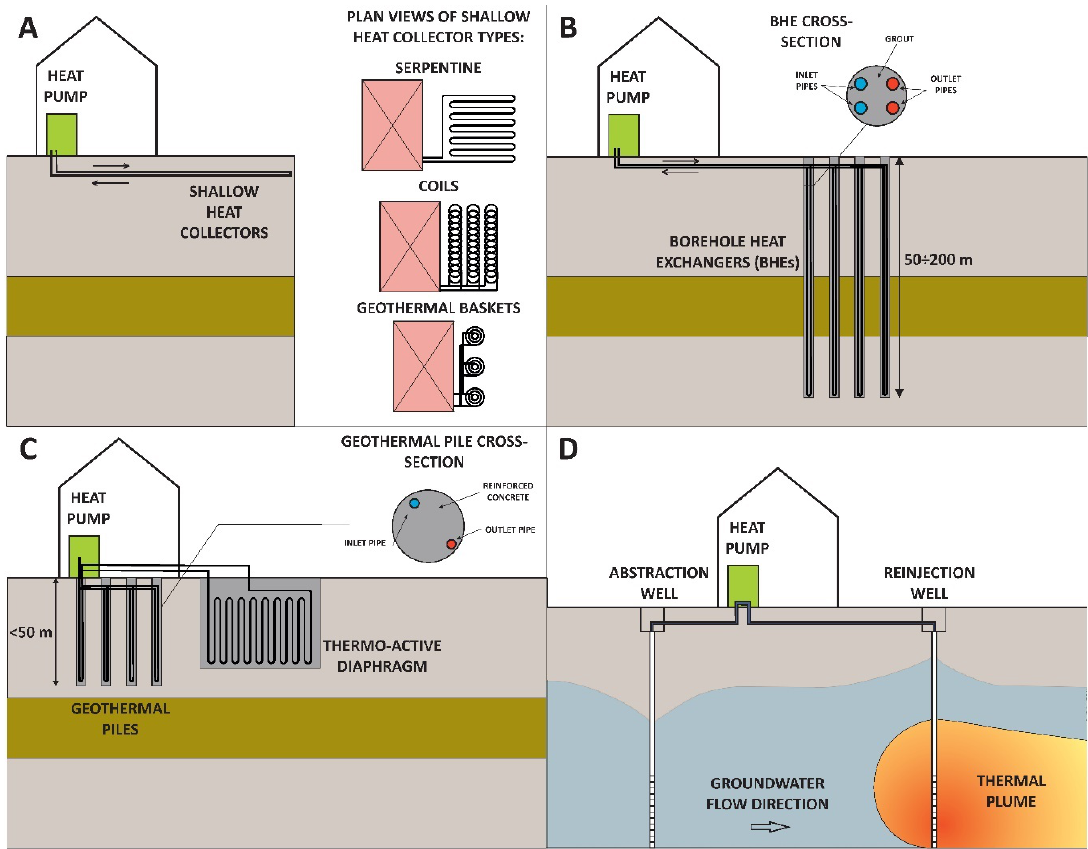
Figure 1. Classification of ground source heat pump (GSHP) systems: closed-loop horizontal heat exchangers ( A ), borehole heat exchangers (BHEs) ( B ), geo-structures ( C ), and open-loop systems ( D ). Modified from the work of [6].